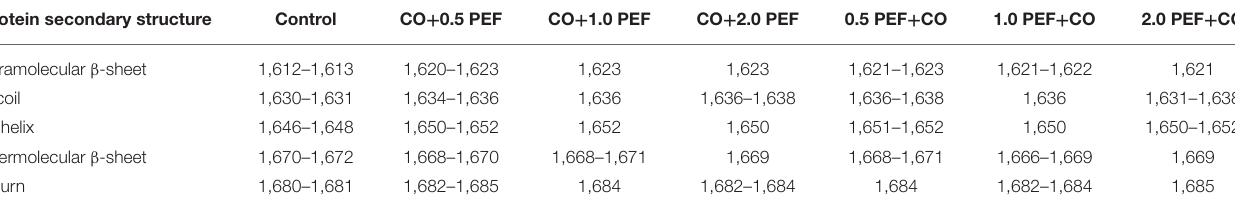
TABLE 4 | Wavelength (cm − 1 ) assignment of protein secondary structures in Amide I region of pretreated freeze-dried samples determined by Fourier transform IR (FTIR) spectroscopy. Protein secondary